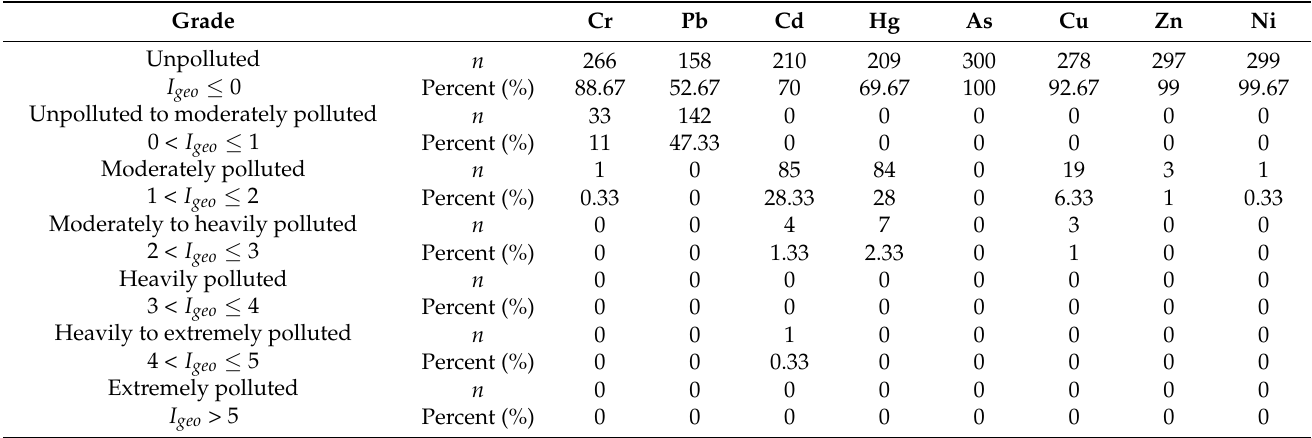
Table 2. Pollution status assessed by geo-accumulation index ( n = 300).